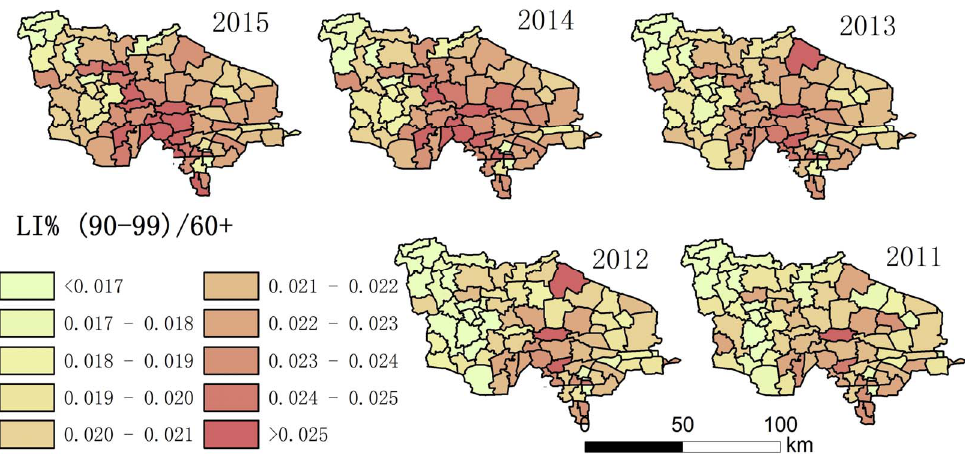
Figure 4. The proportion of people aged 90–99 in the aging population (LI%) of each town.